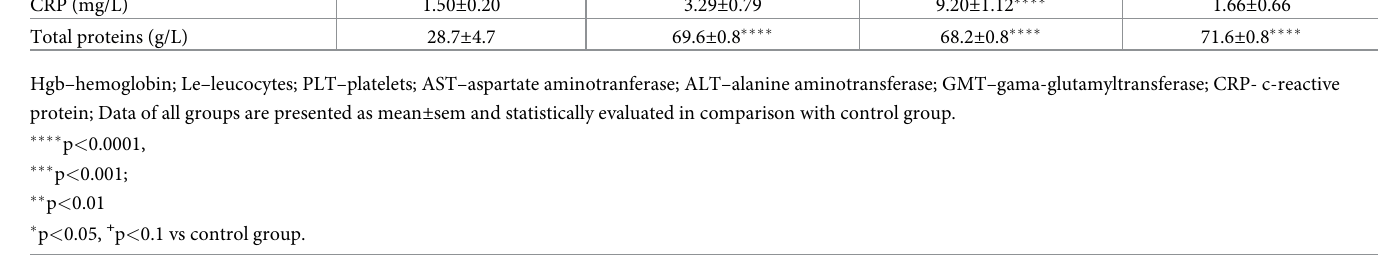
Hgb–hemoglobin; Le–leucocytes; PLT–platelets; AST–aspartate aminotranferase; ALT–alanine aminotransferase; GMT–gama-glutamyltransferase; CRP- c-reactive protein; Data of all groups are presented as mean ± sem and statistically evaluated in comparison with control group.